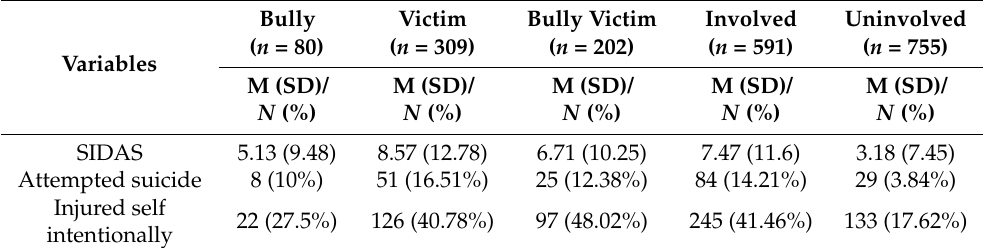
Table 2. Means, standard deviations, and proportions for suicidal thoughts and behaviors in each